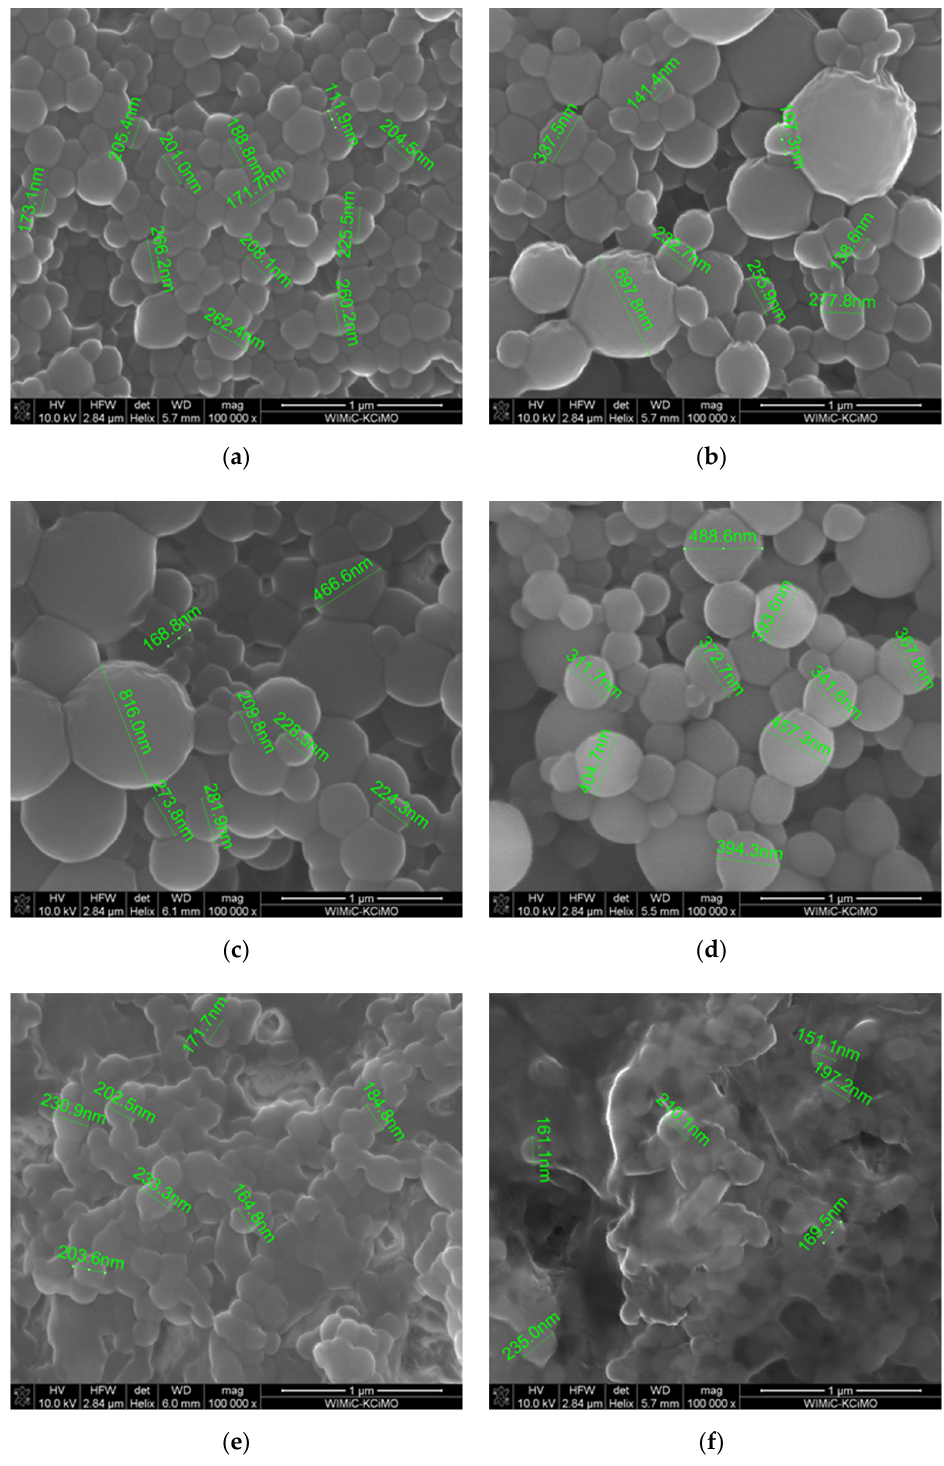
Figure 2. SEM images: ( a ) BSA NPs; ( b ) BSA CLB ‐ 0.25 NPs; ( c ) BSA CLB ‐ 0.5 NPs; ( d ) BSA CLB ‐ 1 NPs; ( e ) BSA CLB ‐ 1.5 NPs; ( f ) BSA CLB ‐ 2 NPs. Different models were fitted for the profiles recorded within the first three hours (due to their linearity) to determine the kinetics and the release mechanisms of CLB (Table 2). Circular dichroism (CD) was used to study BSA and BSA NPs secondary structure, both in the absence and presence of CLB (BSA CLB-0.25 NPs-BSA CLB-2 NPs) (Figure